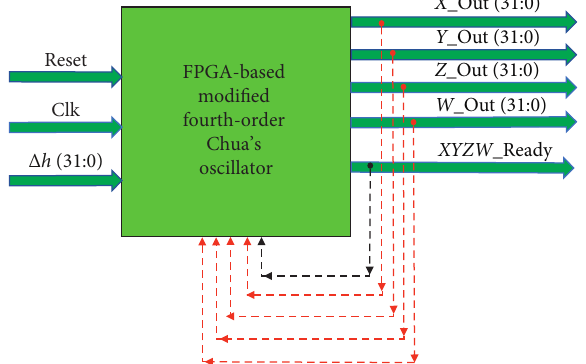
Figure 15: The top level block diagram of the FPGA-based multistable modified Chua’s chaotic system.